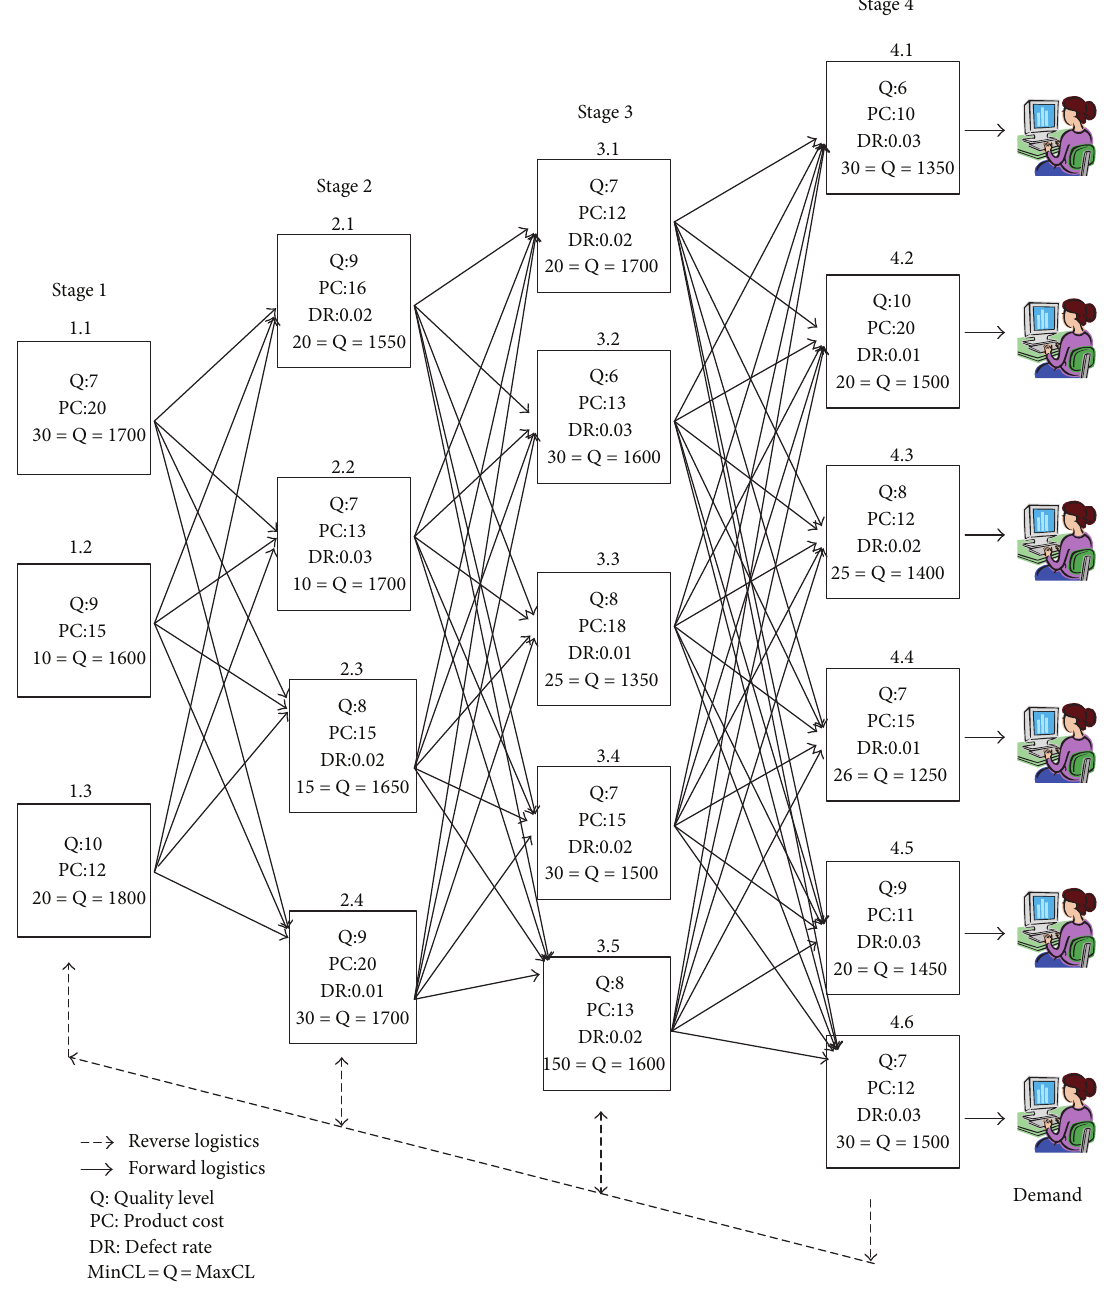
Figure 10: { 3-4-5-6 } forward and reverse supply chain